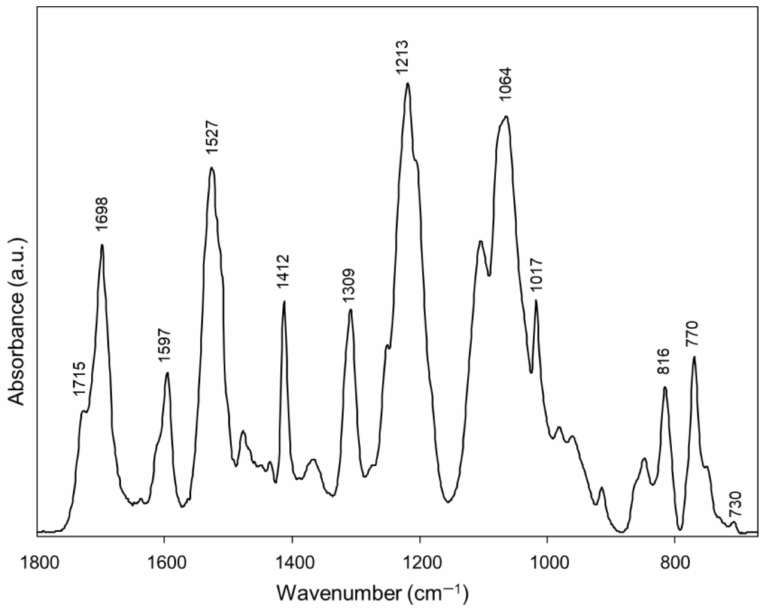
Figure 1. IR spectrum of a Ctrl portion of Invisalign ® aligner.